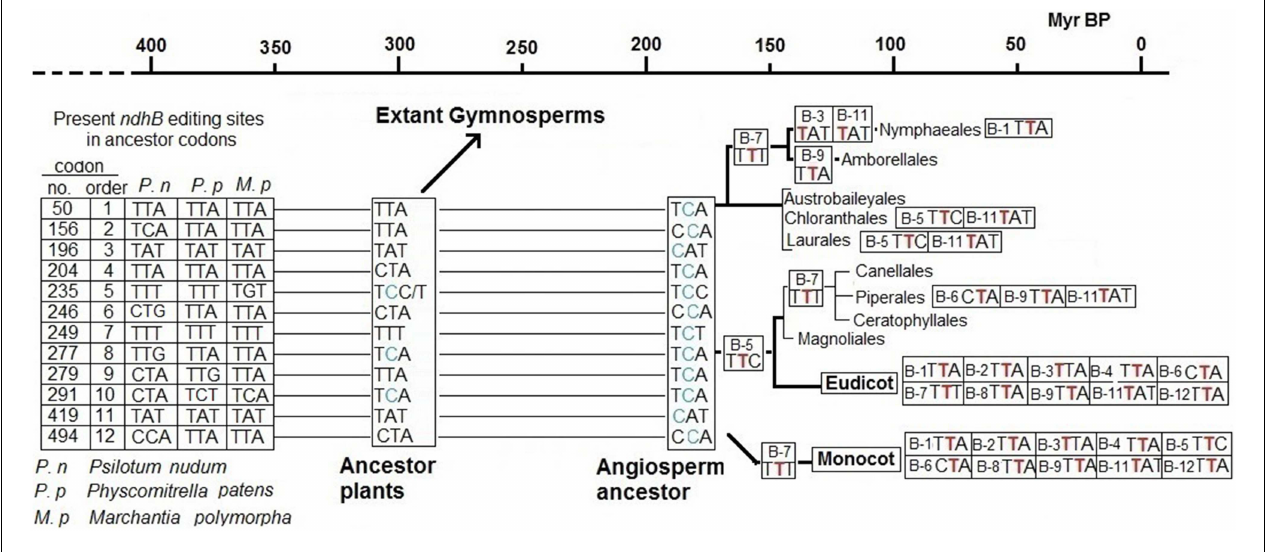
FIGURE 3 | Timing for the creation and correction of editing sites of ndh genes. Specific Cs of codons B-5, B-8, and B-10 of non-flowering plants were T-to-C mutated (new C marked in blue) in a common ancestor of gymnosperms and angiosperms around 300 Myr BP. Additional Ts of the other nine editing sites were mutated to C (blue) between 300 and 170 Myr ago in the ancestor of extant angiosperms completing the 12 editing sites of the ndhB gene. Probably also between 300 and 170 Myr BP, similar T-to-C